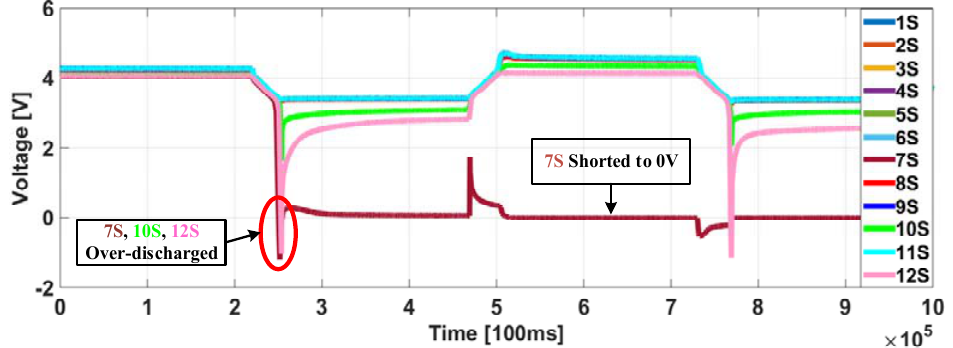
Figure 4. Difference in 12 cell voltages of each representative cell, measured using a voltage sensor, in the retired series/parallel battery pack consisting of 28 parallel ‐ connected cells according to the discharging/charging current profile for aging (1C ‐ rate).